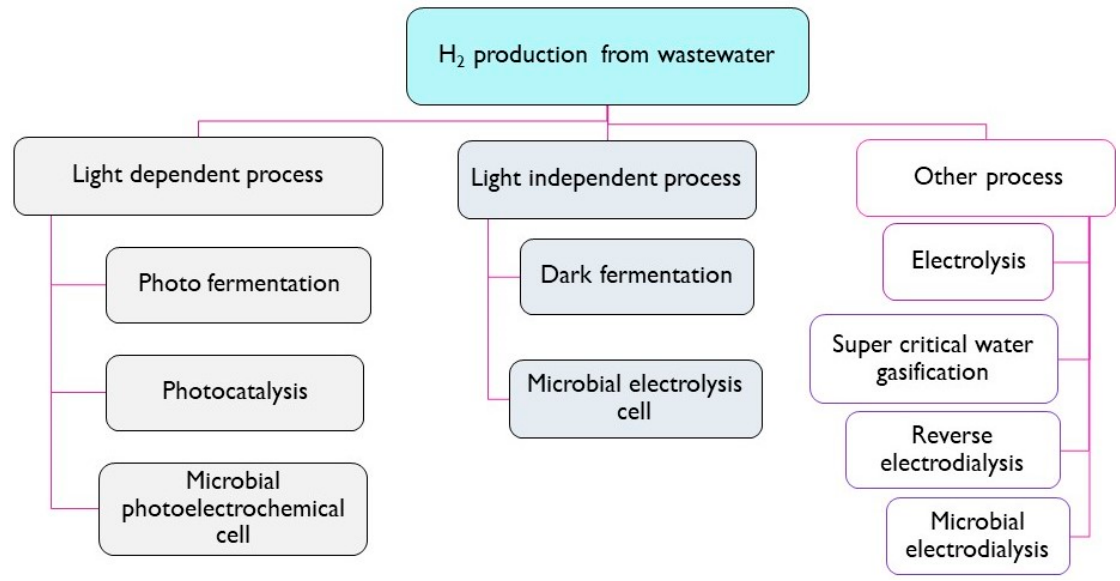
Figure 3. Classification of hydrogen production processes from wastewater [18].